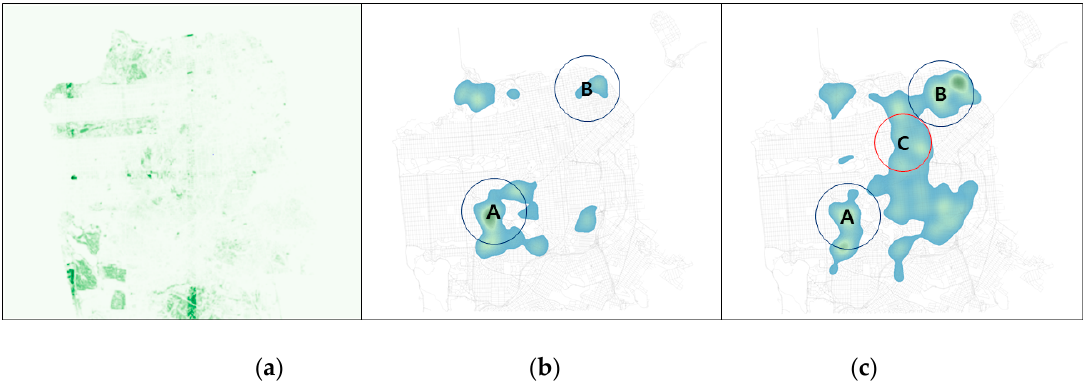
Figure 6. Comparison of significant areas in San Francisco. ( a ) NDVI analysis result; ( b ) UGA heat map with choice 1600 m setting; ( c ) UGA heat map with integration 1600 m setting.